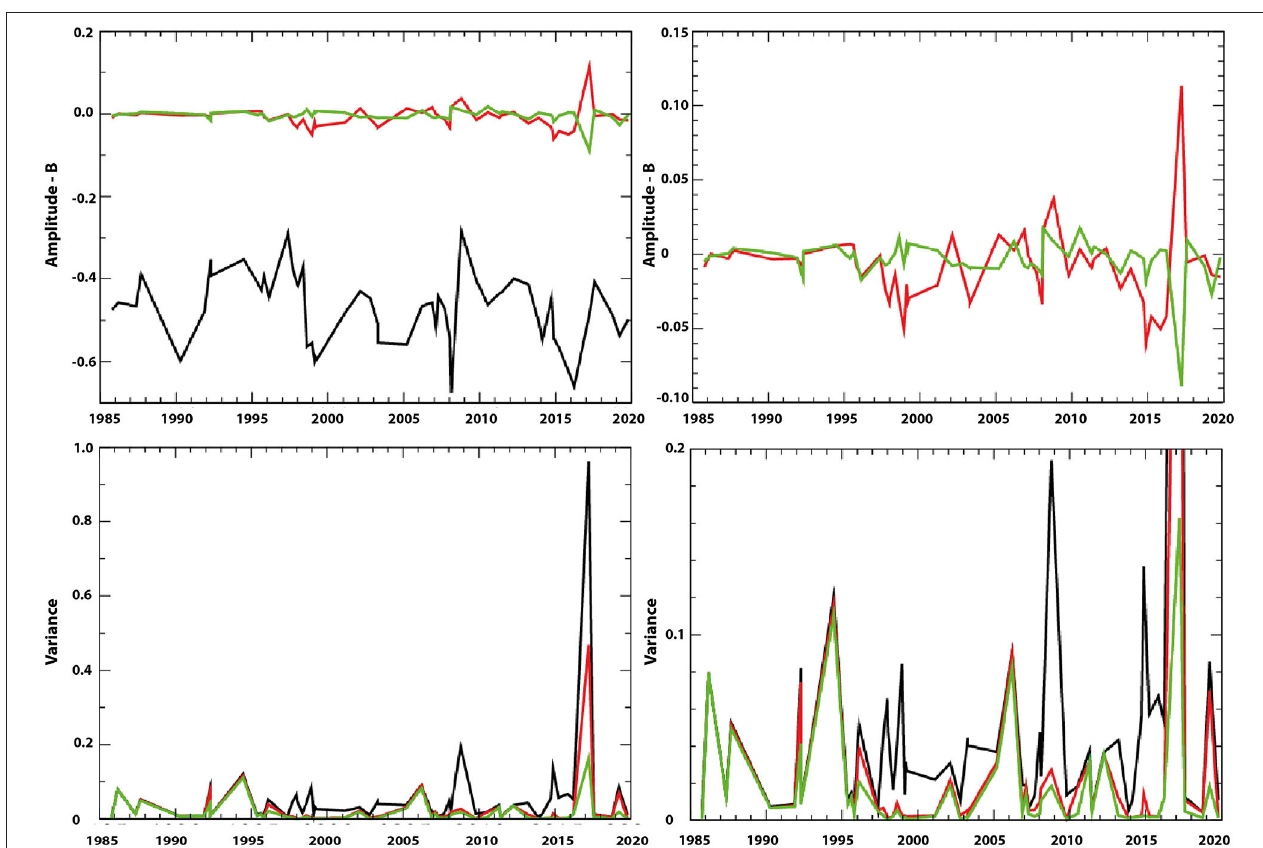
FIGURE 3 | (Upper) Evolution of the amplitudes of the sine modes B 1 (black), B 2 (red), and B 3 (green). The vertical scale gives the temperature difference between the 750 m time series and the maximum profile depth (1,219 m) of the corresponding mode. (Lower) Part of variability not explained by B 1 (black), B 1 + B 2 (red) or B 1 + B 2 + B 3 (green) (left) and zoom (right). Figures on the right show the same data magnified.